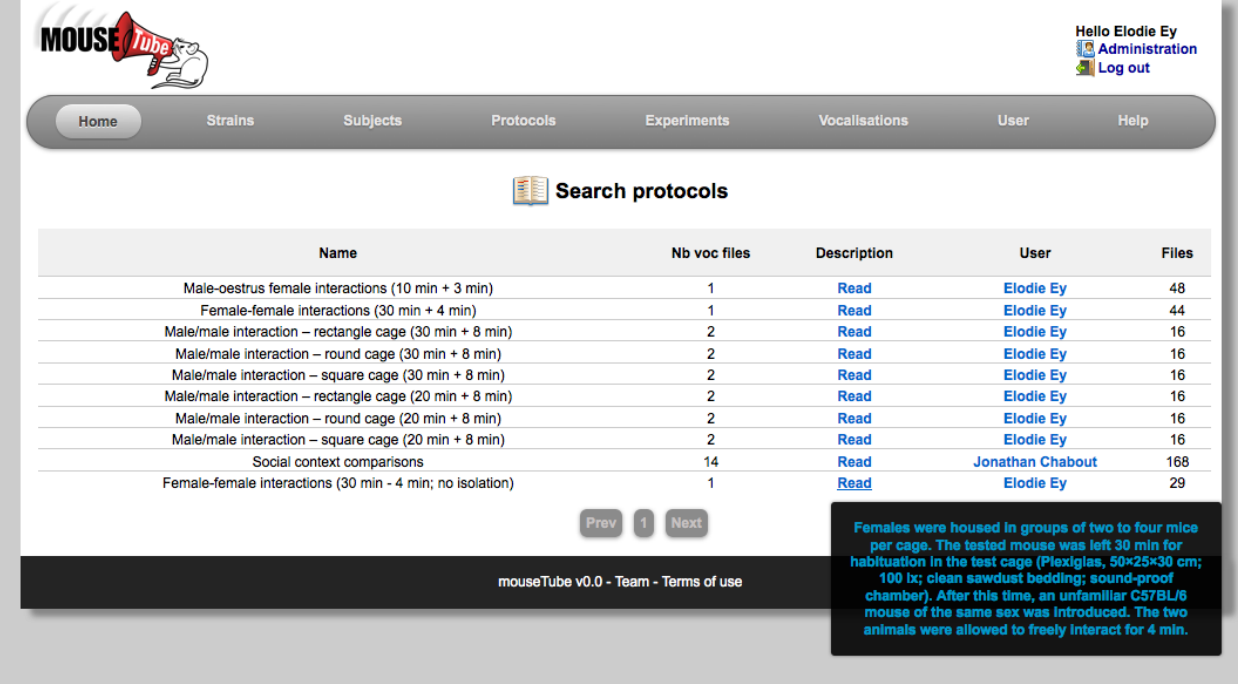
Figure 2. Screenshot of the mouseTube web application on the search page for